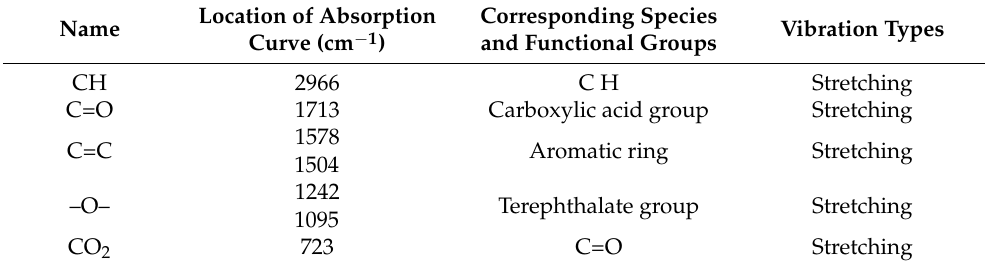
Table 2. Specific functional groups’ FTIR absorption wavenumbers.